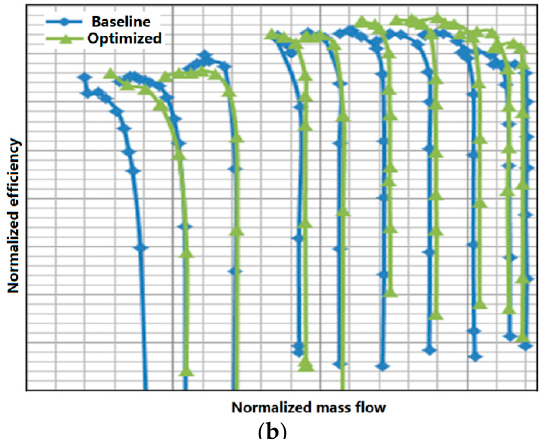
Figure 21. Results of aerodynamic performance test: ( a ) diagram of normalized pressure ratio with respect to normalized mass flow; ( b ) diagram of normalized efficiency with respect to normalized mass flow.